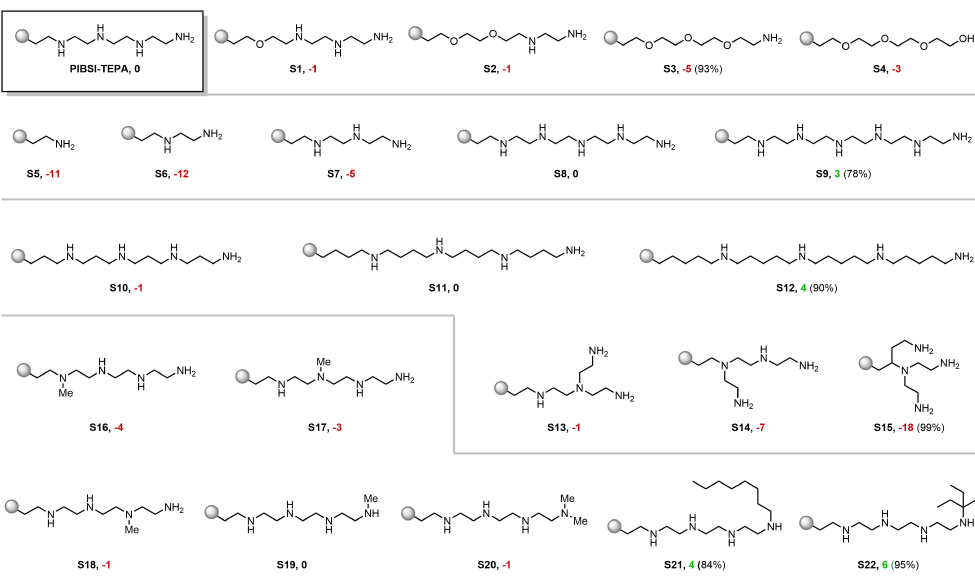
Figure 4. Virtual screening of PIBSI-TEPA derivatives. The values following the product number indicate the difference between the mean posterior predictive blotter dispersancy and PIBSI-TEPA’s experimental value used for training (85%). The percentage in parenthesis expresses the certainty of the Bayesian model for placing the prediction above (for cases in which the predictive mean is above 85%, represented in green) or below (for cases in which the predictive mean is below 85%, represented in red) the PIBSI-TEPA